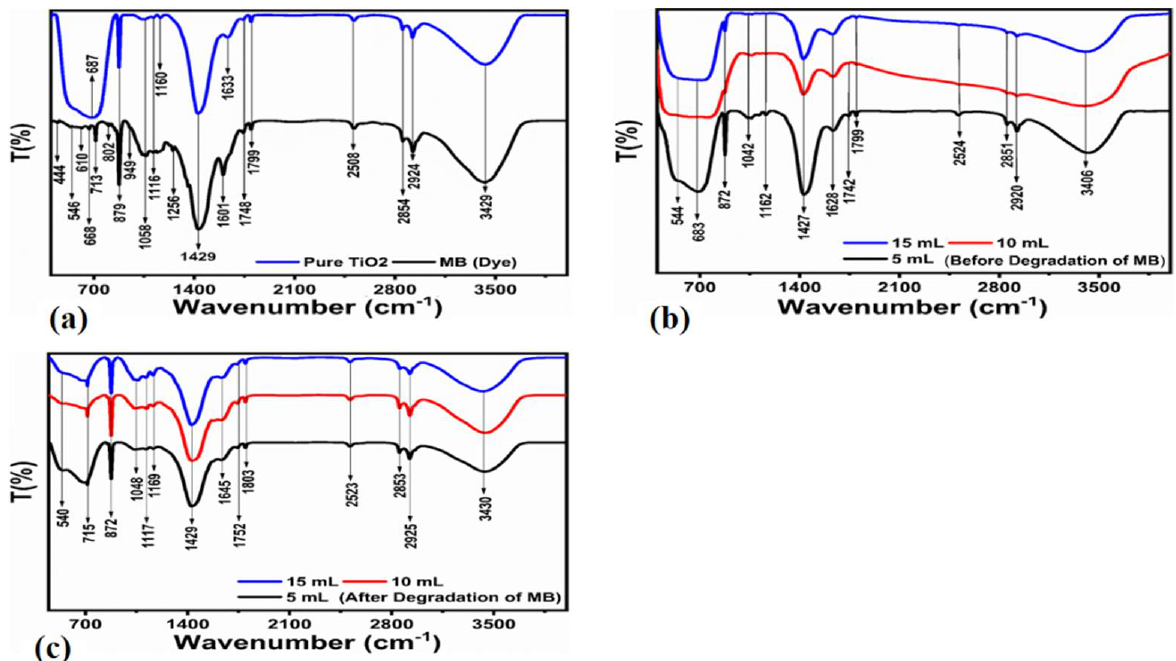
Figure 4. FTIR spectrum of bulk TiO 2 that has been hydrothermally treated and MB ( a ), FTIR spectrum of TiO 2 treated with 5, 10, and 15 mL of FC leaf extract before degradation of MB ( b ) and FTIR spectrum of TiO 2 treated with 5, 10, and 15 mL of FC leaf extracts before degradation of MB ( c ) .